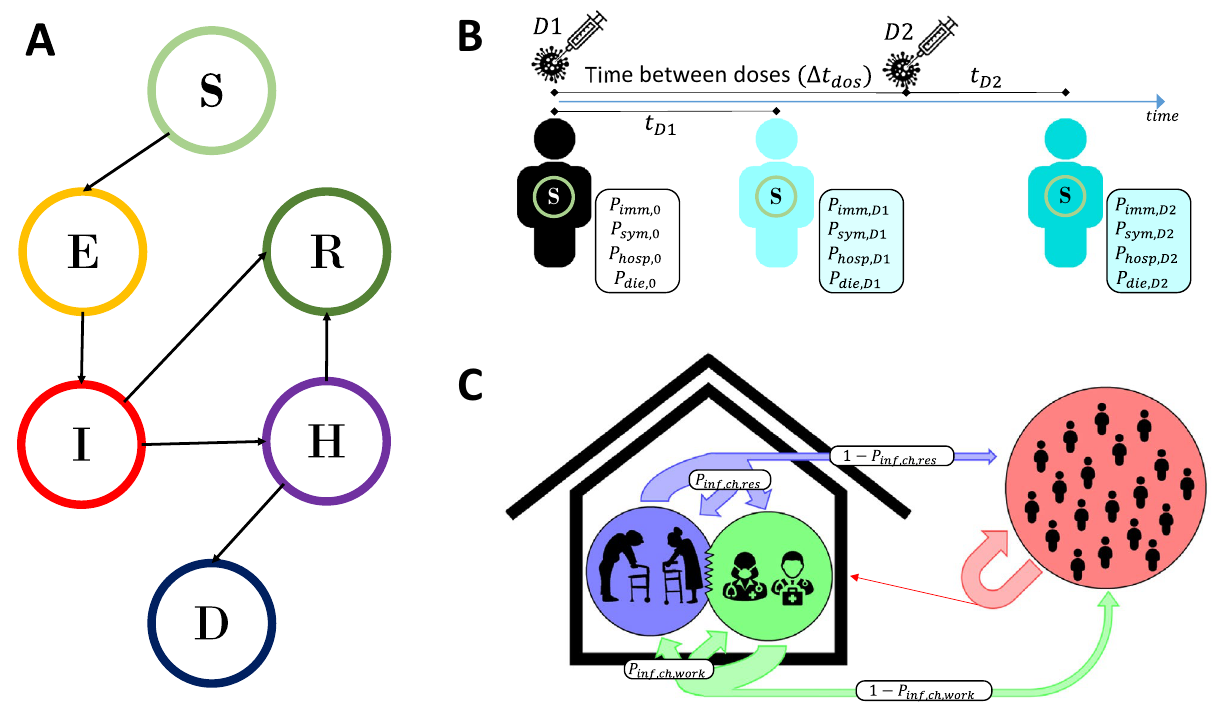
Figure 1. Overview of the agent-based model, showing ( A ) the main individual states and transitions between them; ( B ) the vaccination model: 2-dose regimen and individual variables affected by each dose; and ( C ) care homes: residents, workers, and potential visitors. S = Susceptible, E = Exposed, R = Recovered, I = Infected, H = Hospitalised, D =